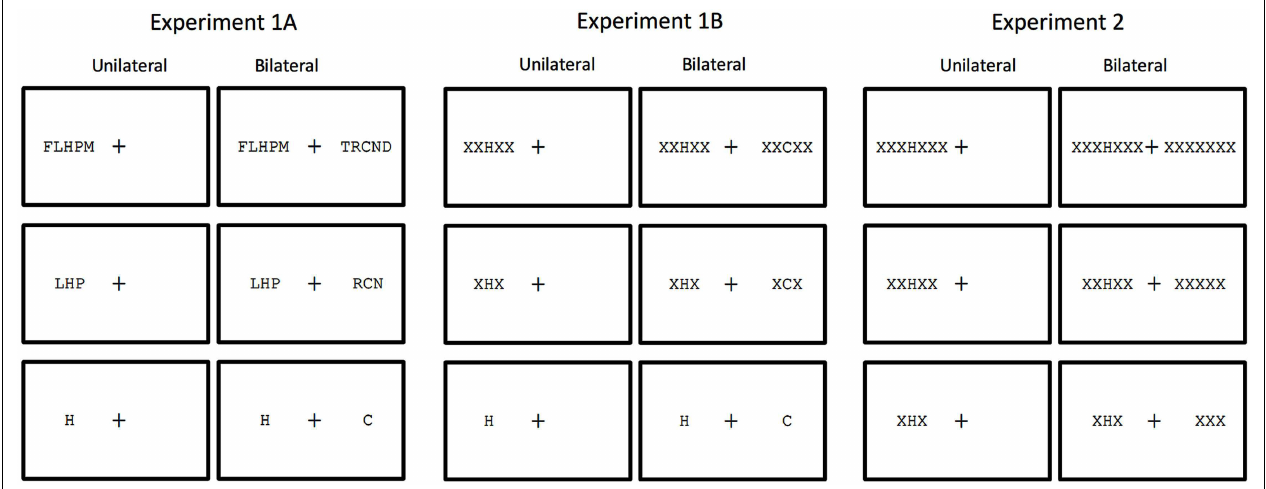
FIGURE 1 | Summary of the conditions tested in the present study in which number of flankers (zero, two, four, six) and unilateral vs. bilateral presentation were manipulated. In all examples the target is the letter “H” presented in the LVF. Flankers in Experiment 1 are other letters. Flankers in